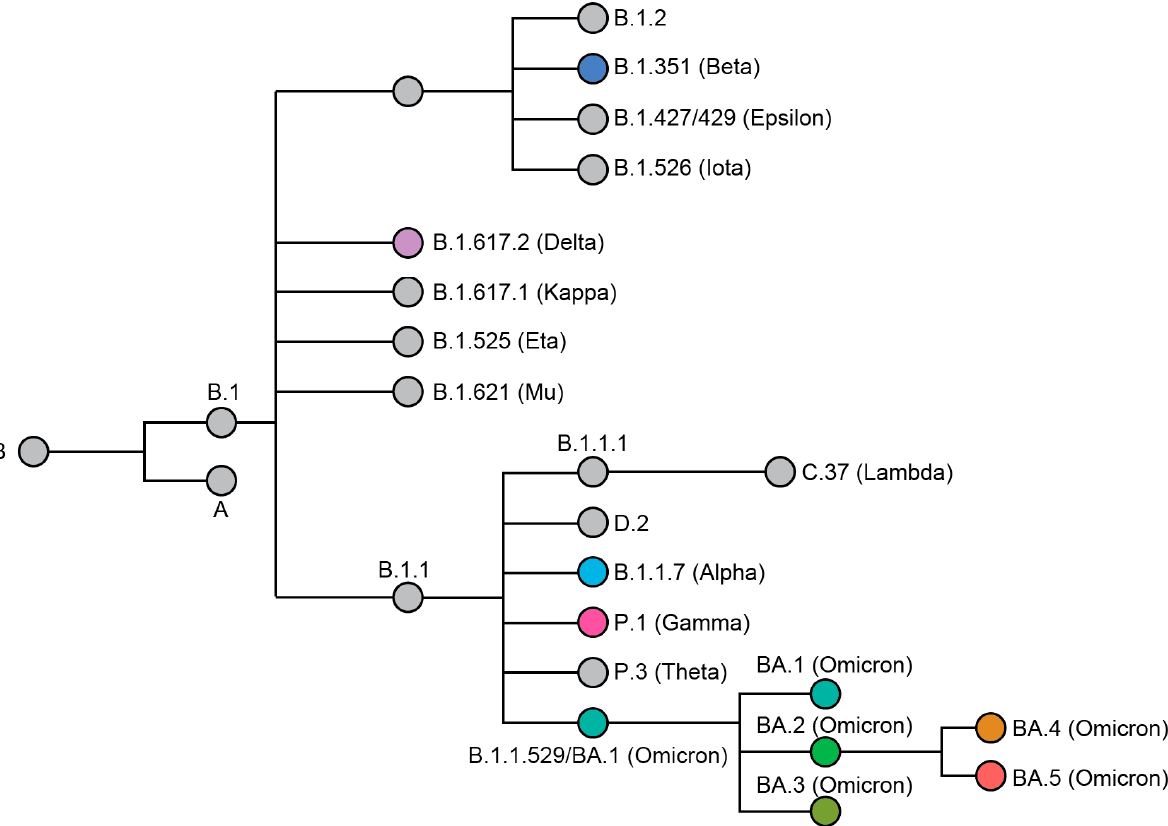
Figure 1. Phylogenetic relationship of named SARS-CoV-2 variants. Variants of concern (VOC) are represented by a colored node. The phylogenetic tree was adapted from data provided by NextStrain, CoVariants (i.e., covariants.org), and Pangolin (i.e., cov-lineages.org) [1,8,13]